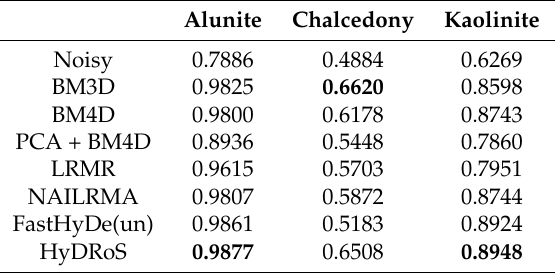
Table 3. AUC obtained by SFF for AVIRIS noise-reduced HSI data at Cuprite Mining